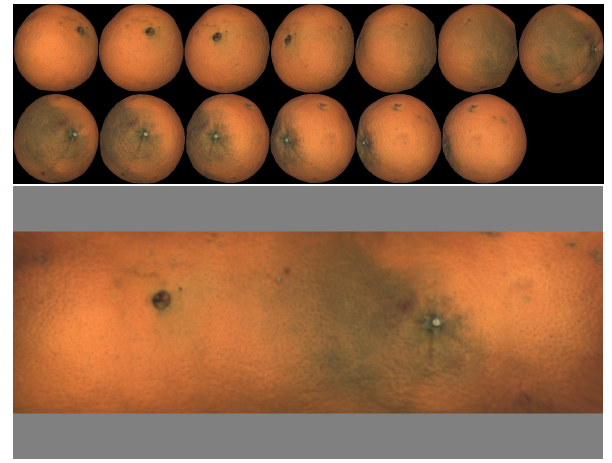
Figure 9. Example of spherical